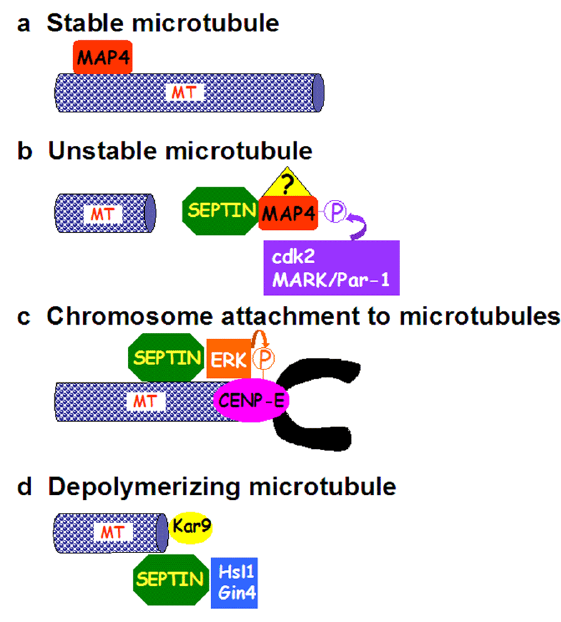
FIGURE 1. Possible mechanisms of regulation of the MT cytoskeleton by septins. (a,b) Septins regulate MT dynamics by regulating the activity of MAPs. (a) MT stability is enhanced when MAP4 binds to them. (b) MTs are unstable when the septin complex binds MAP4 and prevents its binding to MT. Phosphorylation of MAP4 by cdk2, MARK/Par-1, as well as possible other kinases, inhibits MAP binding to MTs. (c) Septins regulate the attachment of chromosomes to kinetochore MTs and chromosome segregation by favoring the localization of CENP-E to kinetochores and its stable attachment with the depolymerizing plus end of kinetochore MTs. Septins might also act as scaffolds for kinases that regulate CENP-E, such as Erk kinase that phosphorylates CENP-E. (d) Septins regulate the correct positioning of mitotic spindles by capturing the MT plus ends via MAP Kar9. Septin-dependent kinases Hsl1 and Gin4 are required for MT catastrophe and the creation of a pulling force on the spindle that moves the spindle toward the septin